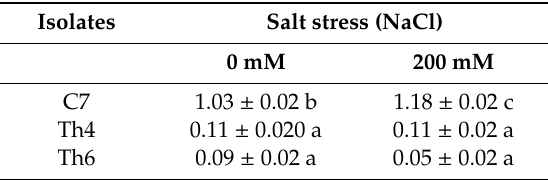
Table 1. Indole-3-acetic acid (IAA) secretion ( µ g mL − 1 ) potential of C7, Th4, and Th6 isolates under nonstress (0 mM) and salt stress (200